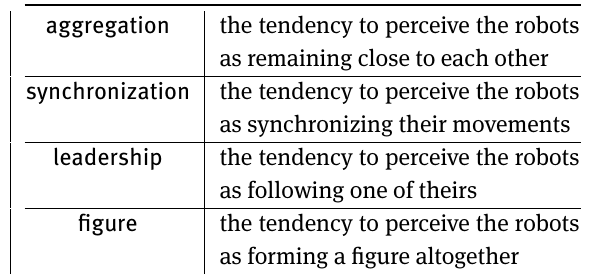
Table 1: The parameters governing the representation of a robot swarm as a coherent